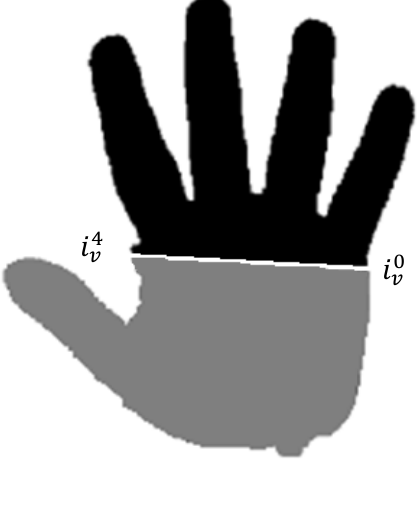
Figure 11. Black regions are the regions of interest when employing the hand shape global appearance features while discarded regions are in